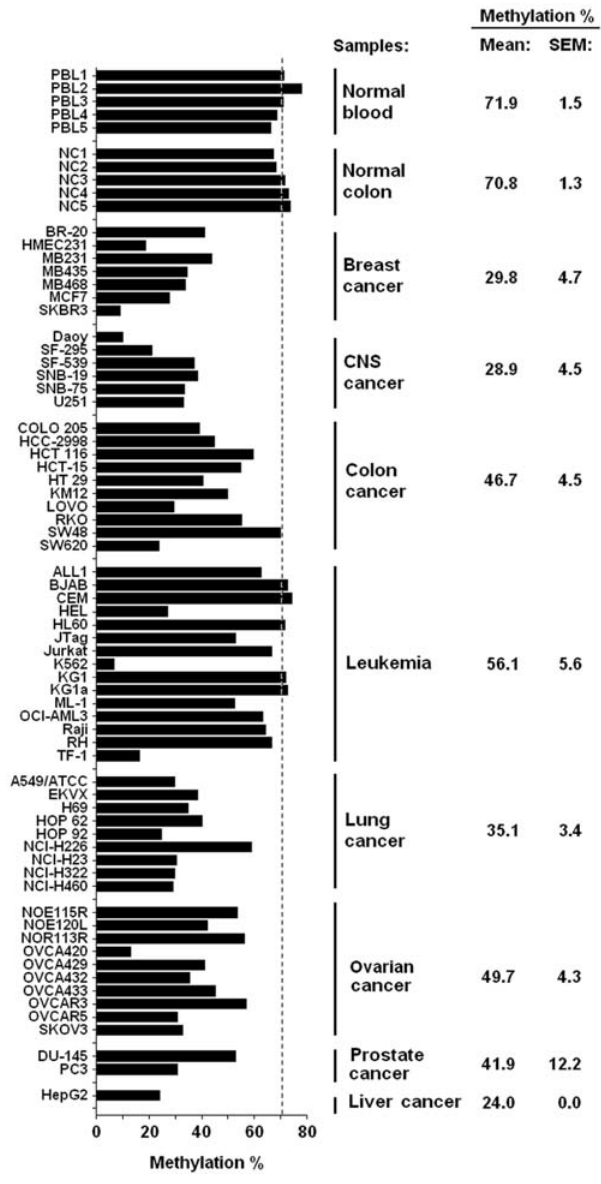
Figure 4. LINE-1 methylation variability in cancer cell lines. DNA samples of normal peripheral blood lymphocyte, normal colon mucosa and sixty-one cell lines from eight different tissues types were investigated for LINE-1 methylation using bisulfite PCR followed by pyrosequencing. The normal tissues presented high levels of LINE-1 methylation (above 70% in average), and a large variation in methylation levels was observed for cancer cell lines, with a minimum methylation density of 6.5% being observed for the leukemia cell line K562. Taken as a group, leukemia cell lines were moderately demethylated (average 56.1%), followed by ovary, colon, prostate and lung cancer cell lines (variation from 49.7% to 35.1%). Central nervous system (CNS), breast and the one liver cancer cell lines tested were deeply demethylated (bellow 30% in average). Dotted line represents average methylation in normal